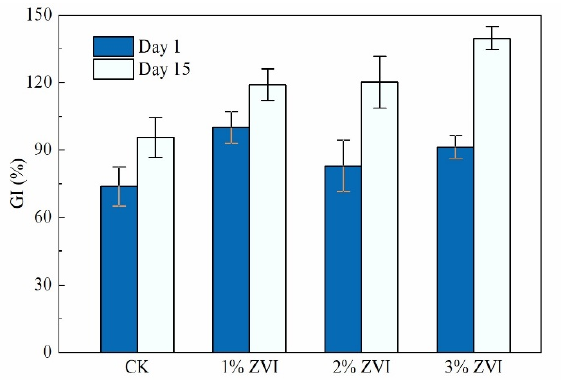
Figure 6. Germination index of sewage sludge compost under different ZVI additions. ZVI: zero- valent iron.